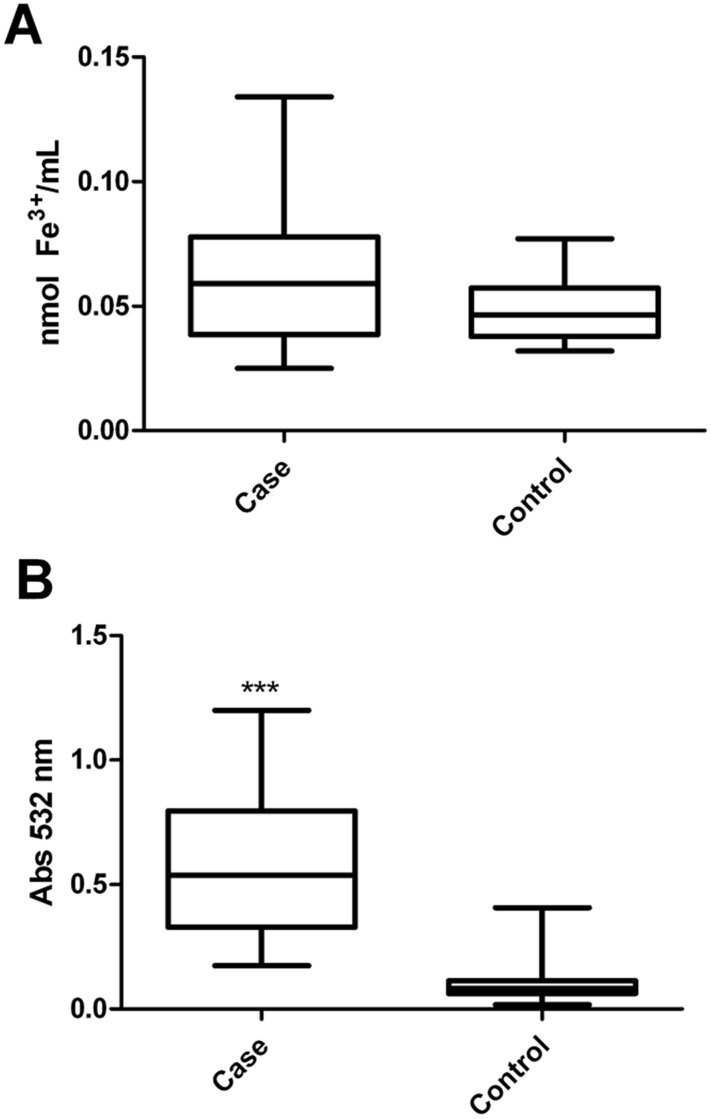
Iron overload effect on oxidative stress.(A) Content of Fe3+ in the residual plasma of individuals with or without iron overload: n = 24 (case) and n = 14 (control), p = 0.087 (Mann Whitney). (B) Lipid peroxidation in subjects with or without iron overload: n = 14 (case) and n = 14 (control), p<0.0001 (Student's t test). All experiments were performed in triplicate and the line in bars represented the mean and the error bar denotes SEM.